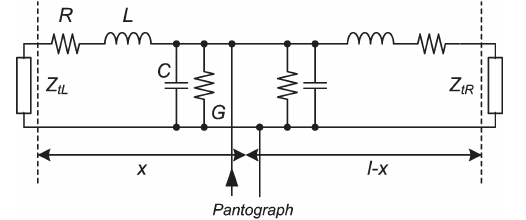
Figure 3. Simplified model of the impedance seen by the train pantograph.